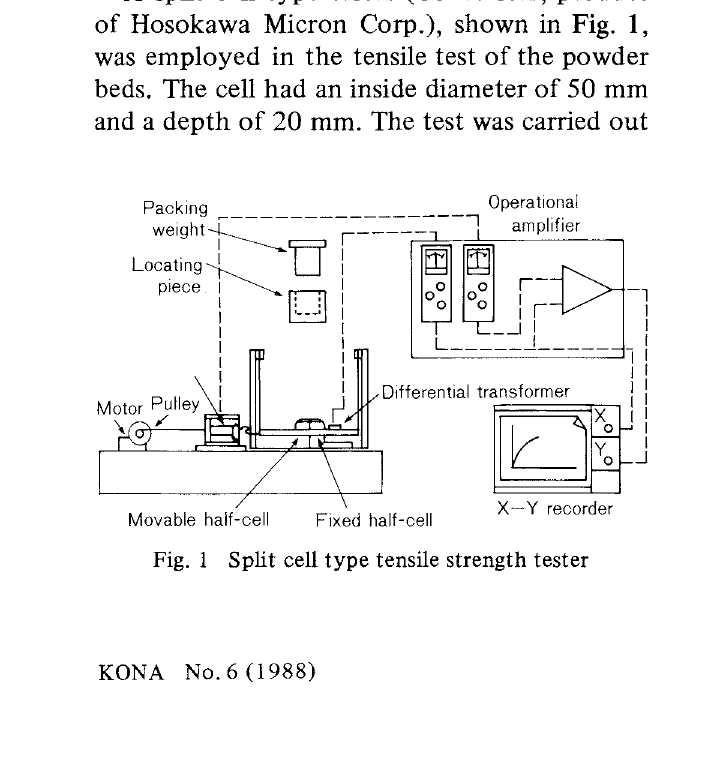
Fig. 1 Split cell type tensile strength